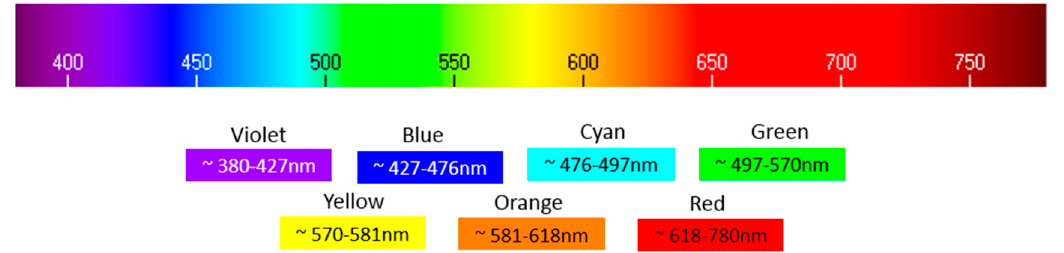
Figure 17. Transmittance values calculated at the tipping point of the calibration lines of Figure 16. Transmittance LED 50%.